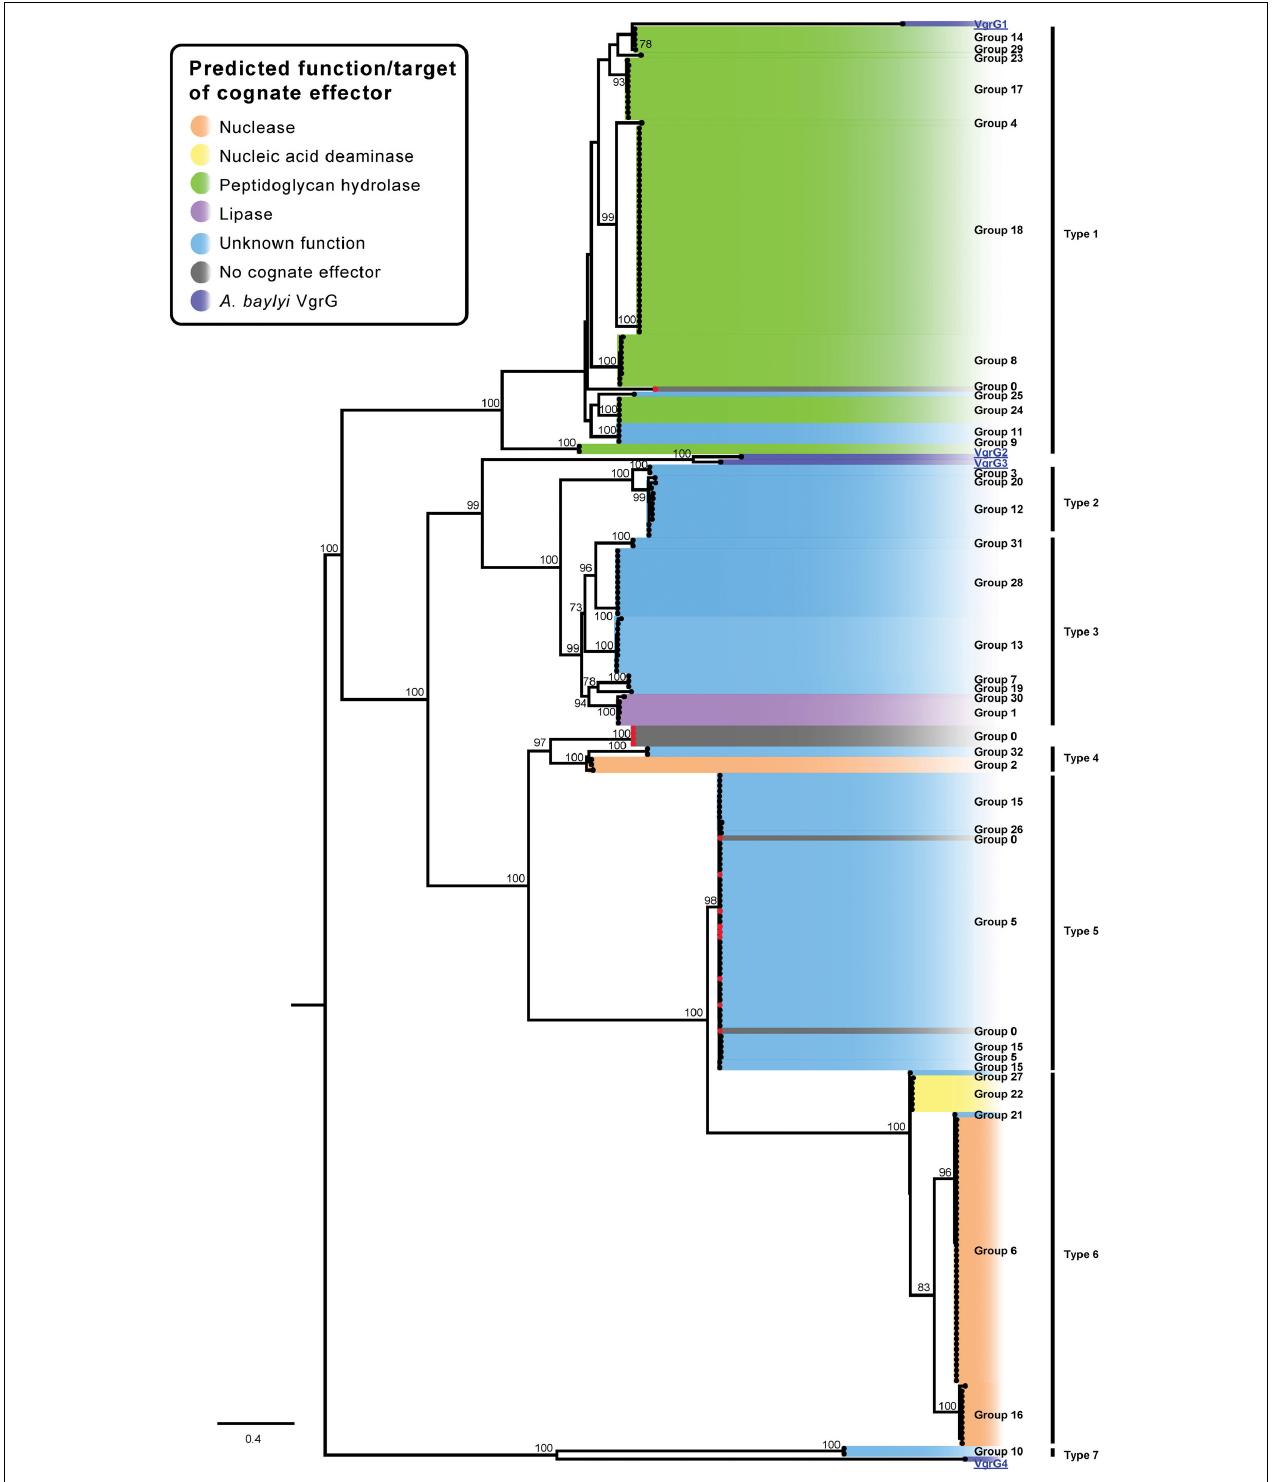
FIGURE 9 | ML phylogenetic tree of A. baumannii VgrG proteins. The tree was generated from the VgrG amino acid sequences using the general ‘variable time’ matrix with the discrete Gamma model (VT + F + G4). A. baylyi ADP1 VgG proteins are included for comparison. The scale bar represents the number of amino acid substitutions. Branch support values ≥ 70 (UFBoot) are shown at all major nodes. Black names represent A. baumannii VgrG proteins, groups 0–32, blue underlined names represent A. baylyi VgrG proteins. A. baumannii VgrG proteins that do have a cognate effector encoded downstream are indicated by a red dot at the end of the branch ( Supplementary Files S3f , S4f ). The different types of closely related VgrG proteins are shown on the right side of the ML phylogenetic tree (Type 1–7).